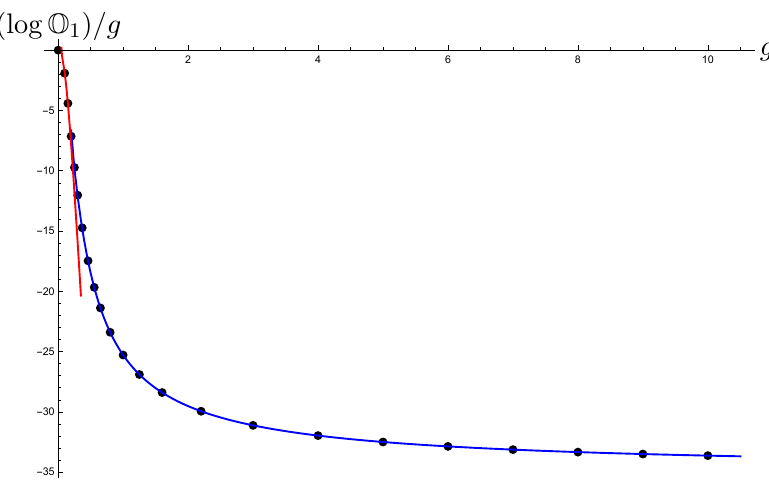
χ ( s ) ) on the coupling constant for y = 10 and b